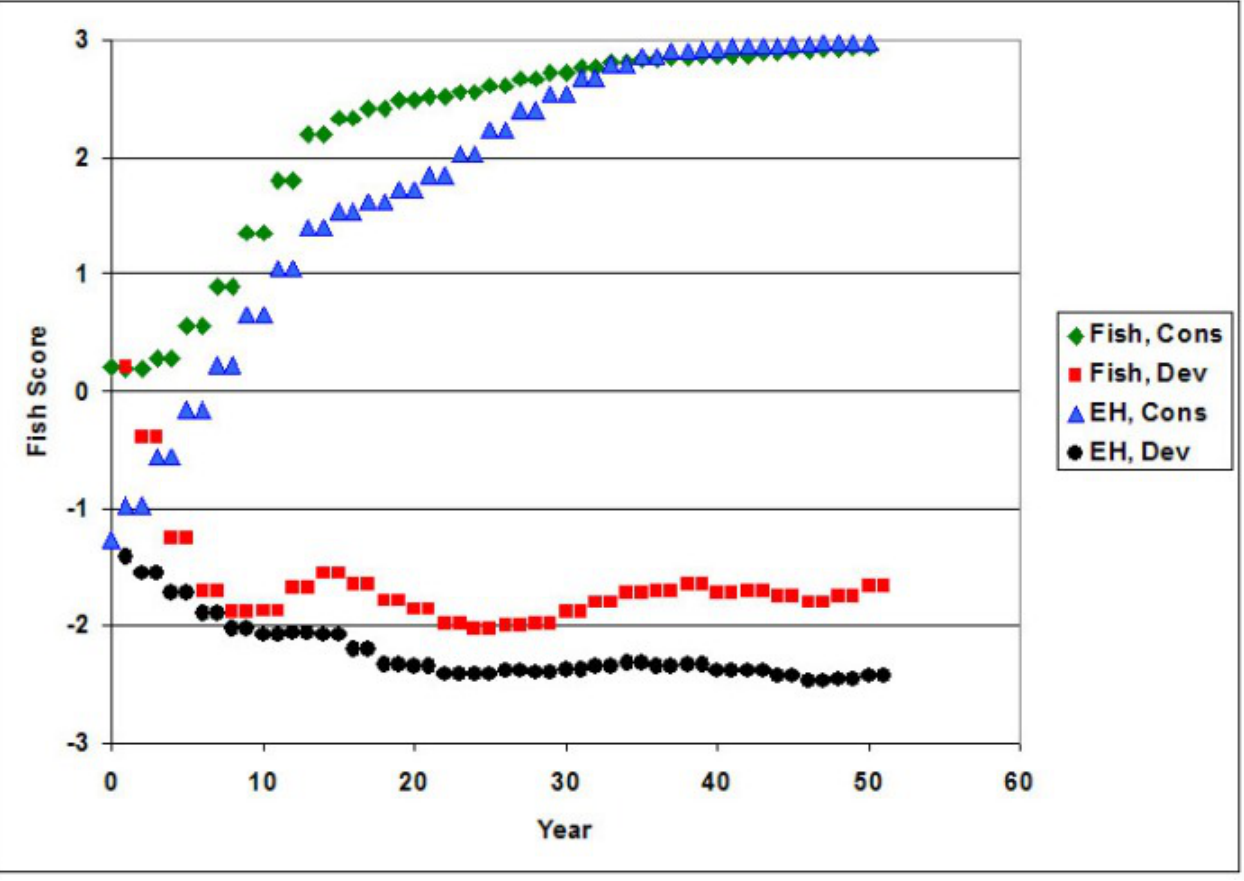
Fig. 10 . Average fish and ecosystem health evaluative model scores by year for 50 runs of the fish conservation and unconstrained development scenarios. The fish evaluative model score for the fish conservation scenario (Fish, Cons) is indicated in green, the fish evaluative model score for the unconstrained development scenario (Fish, Dev)in red, the ecosystem health evaluative score for the fish conservation scenario (EH, Cons) in blue, and the ecosystem health evaluative score for the unconstrained development scenario (EH, Dev) in